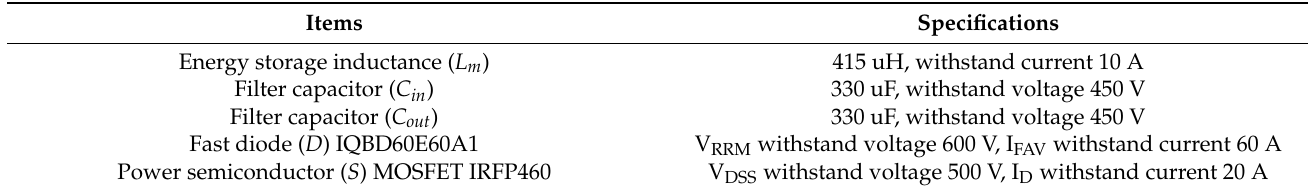
Table 5. Specifications of the main components in the boost converter [25].